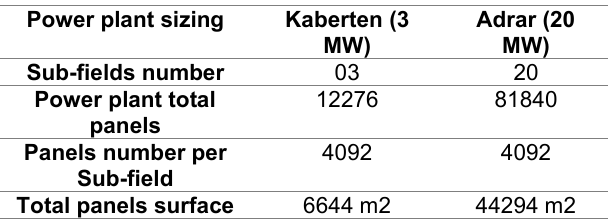
Table 9. Inverter technical specifications